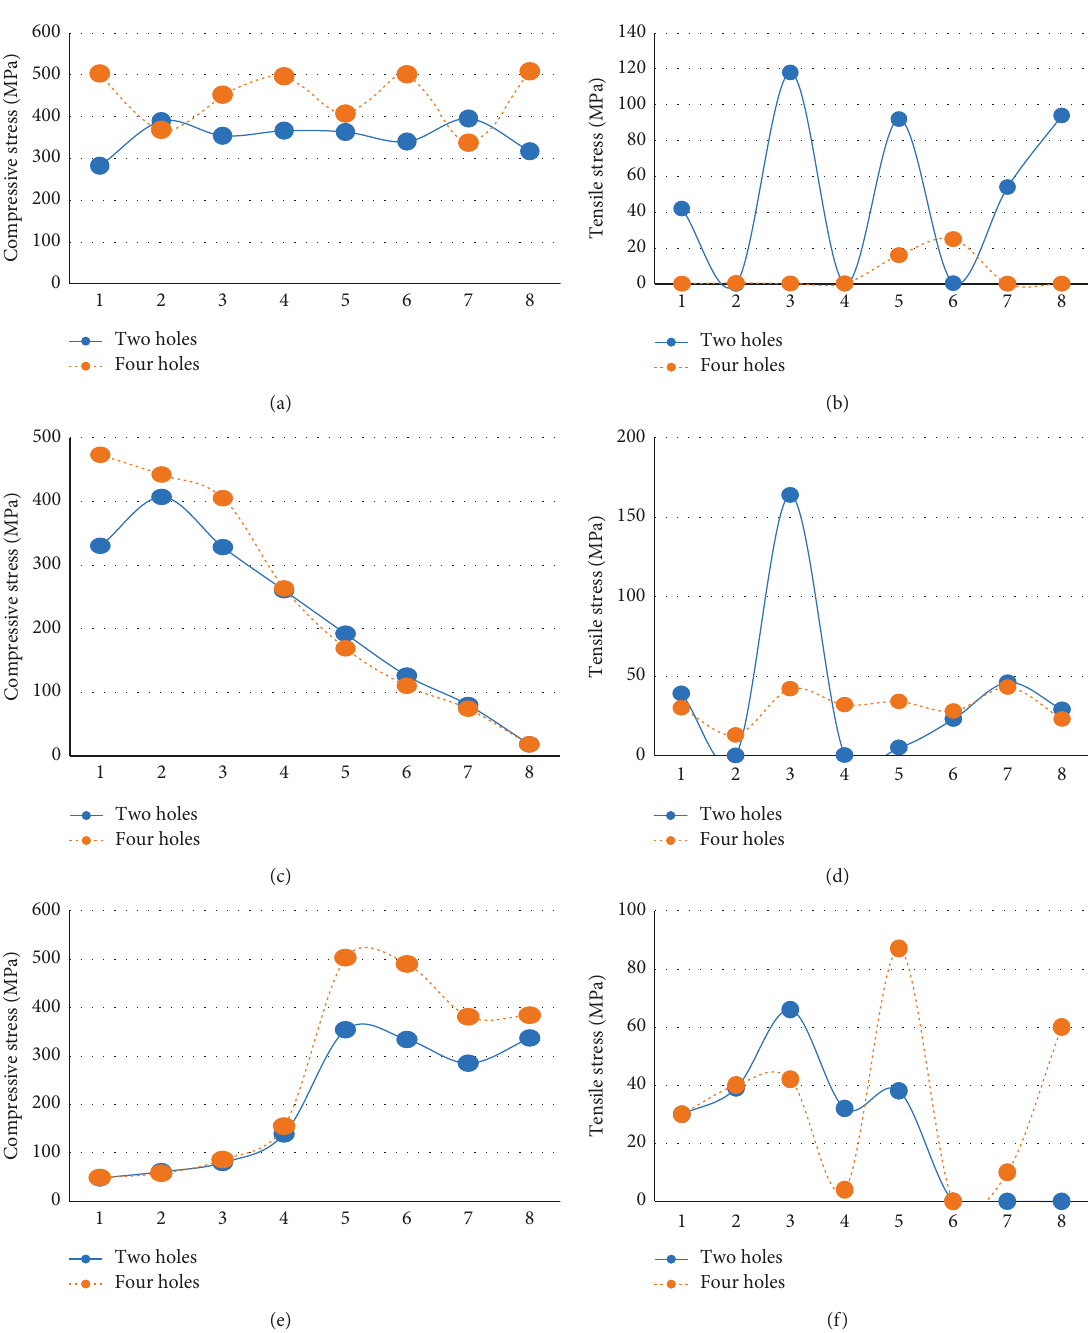
Figure 5: Stress curve of each part of the blasthole. (a) Pressure stress in the charging section. (b) Pulling stress in the charging section. (c) Blocking section compressive stress. (d) Pulling section tensile stress. (e) Rock compressive stress at the bottom of the blasthole. (f) Rock tensile stress at the bottom of the